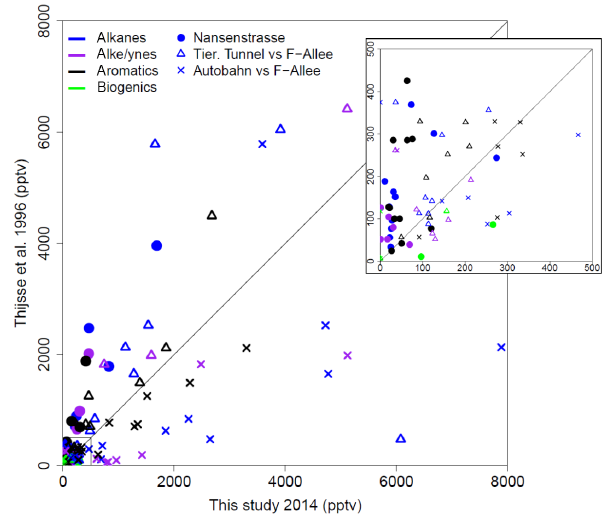
Figure 7. Comparison between VOC measurements in this study and comparable previous work from June to August 1996 (Thijsse et al., 1999). Compound classes are distinguished by color. Sampling locations by plotting